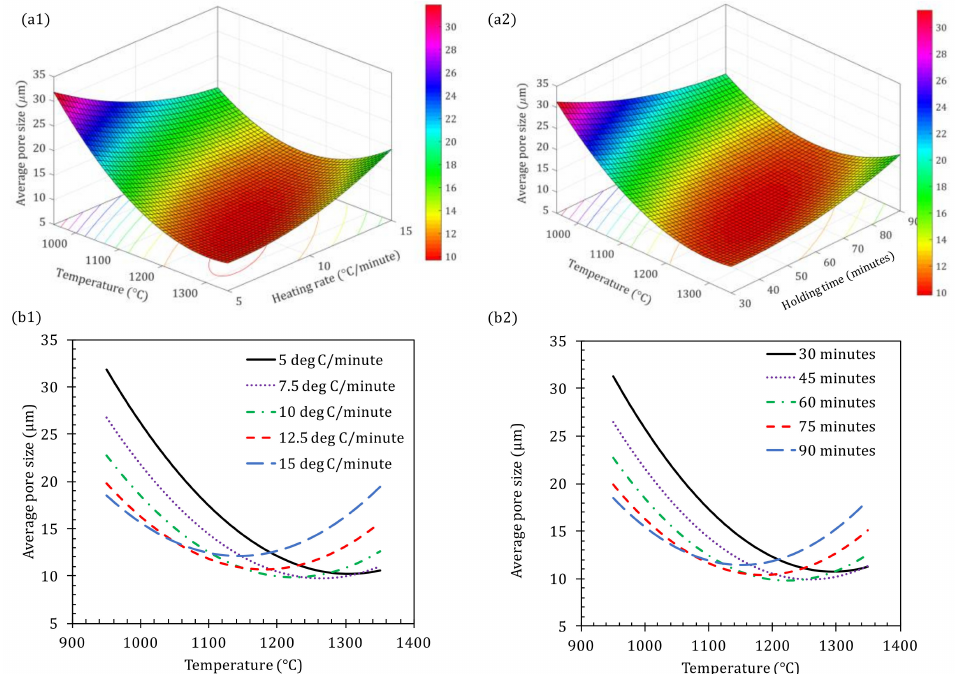
Figure 7. Interaction plots: ( a1 ) Surface plot between temperature versus heating rate; ( b1 ) interaction plot showing the effect of temperature and heating rate on the average pore size; ( a2 ) surface plot between temperature versus holding time; and ( b2 ) interaction plot showing the effect of temperature and holding time on the average pore